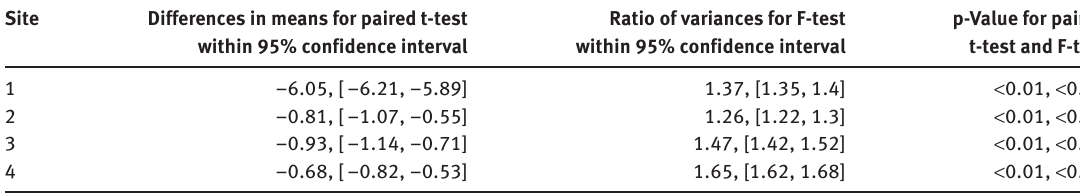
Table 2: Comparisons of Differences between Means and Variances Using Paired t-Test and F-test, p-Value with 95% Confidence Level at Different Sites between the Time of the Day [Day (between 06:00 and 19:59) and Night (between 20:00 and 05:59)].